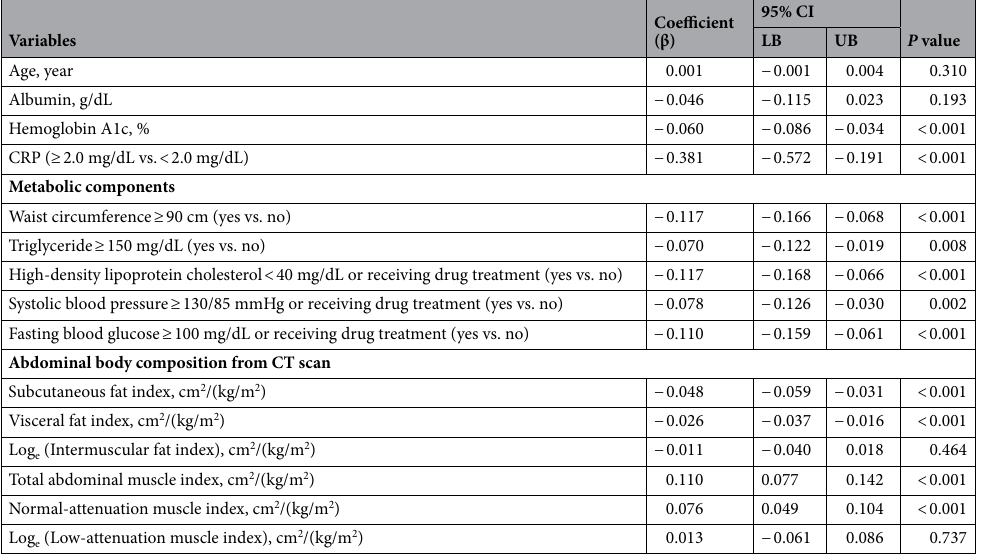
Table 2. Univariable linear regression analysis to determine the relationship with log e -transformed testosterone. CI Confidence interval, LB Lower bound, UB Upper bound, CT Computed tomography.